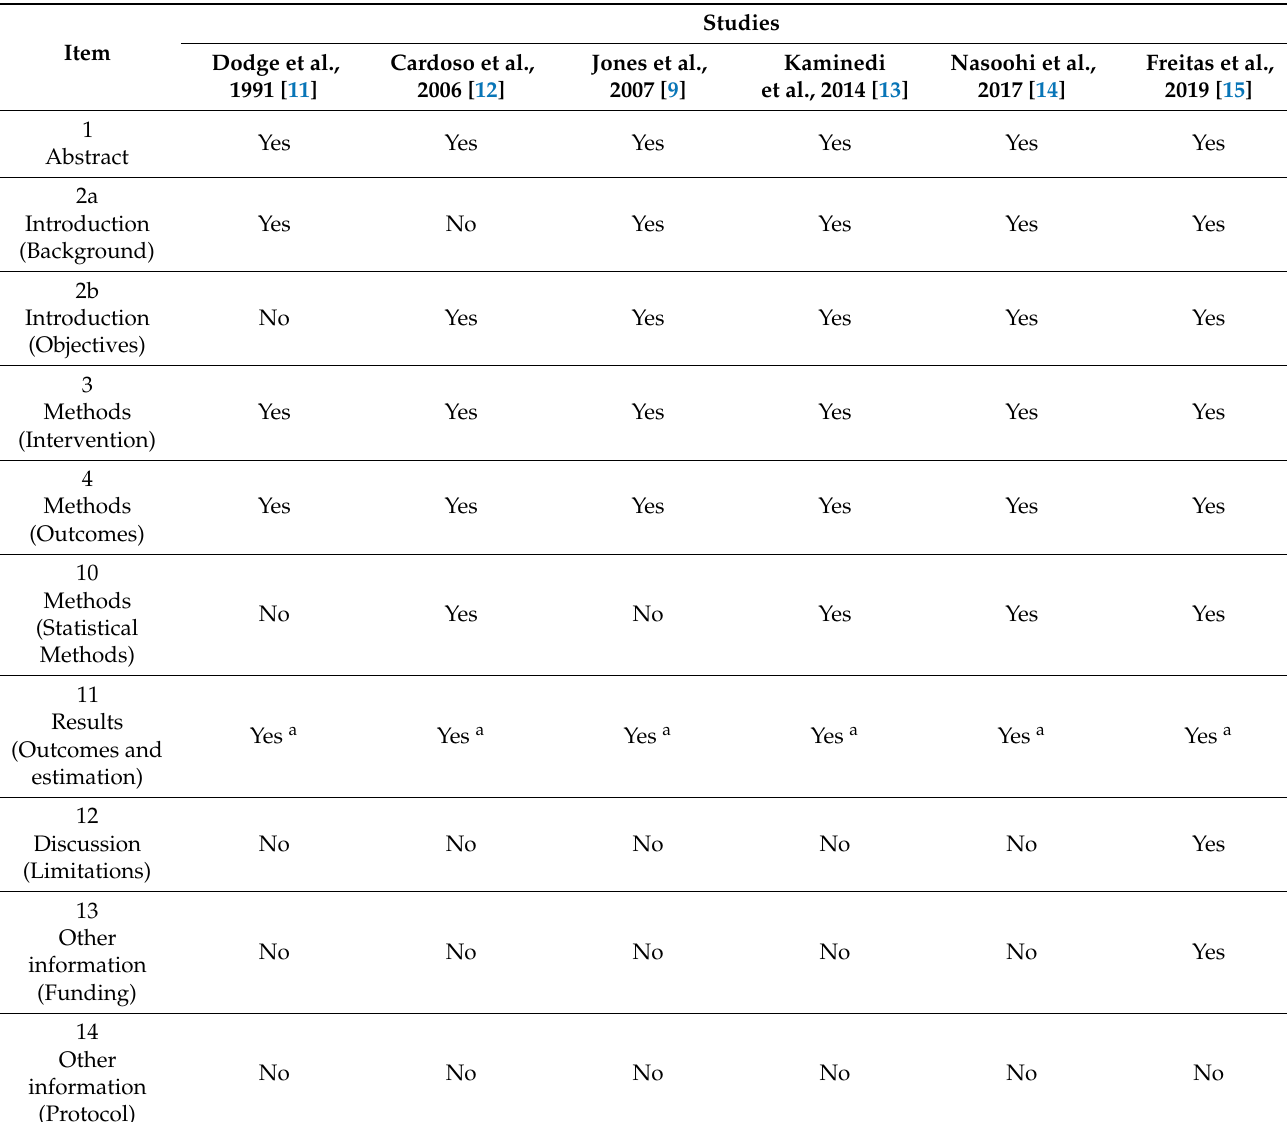
Table 5. Modified Consolidated Standards of Reporting Trials (CONSORT) checklist for reporting in vitro studies of dental